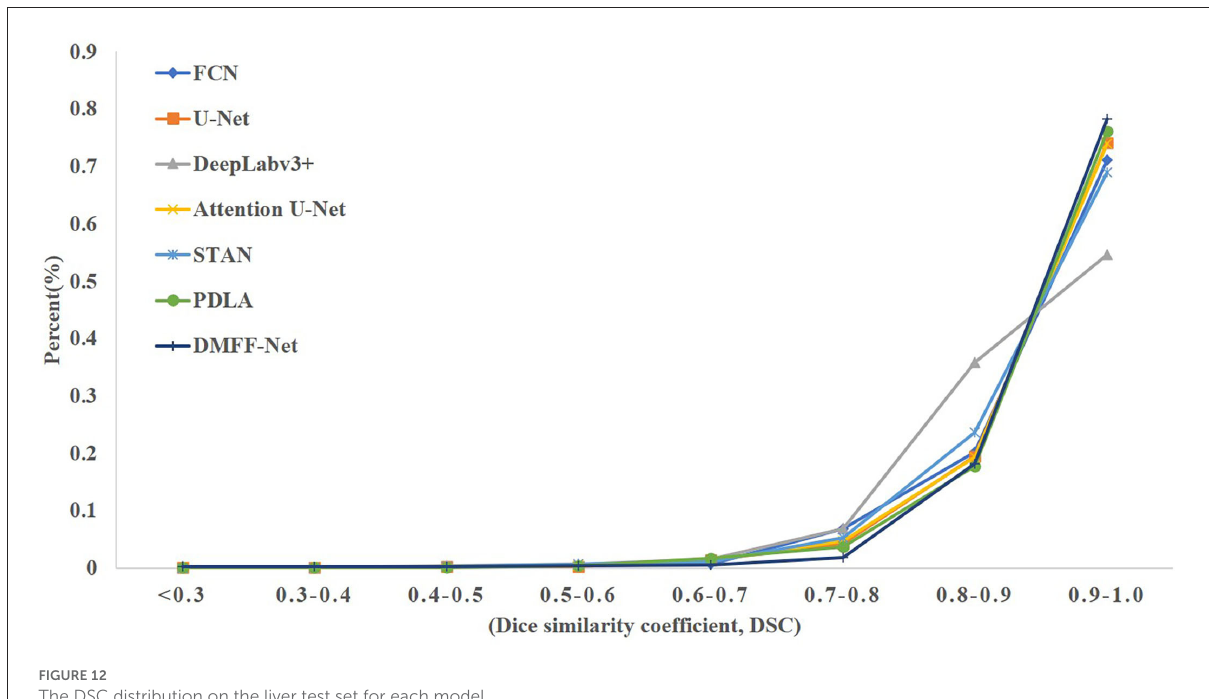
FIGURE12 The DSC distribution on the liver test set for each model.